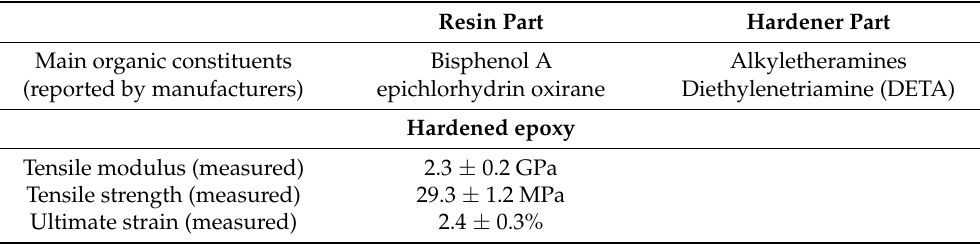
Table 2. Constituents and main properties of the epoxy systems used in the present study.